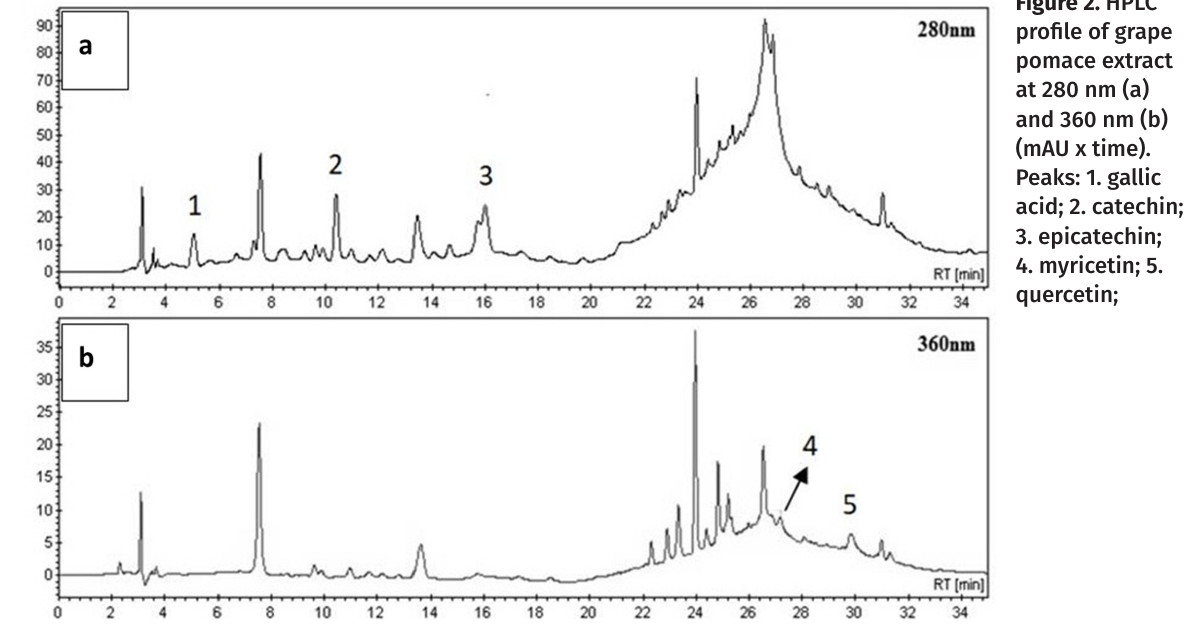
Figure 2. HPLC profile of